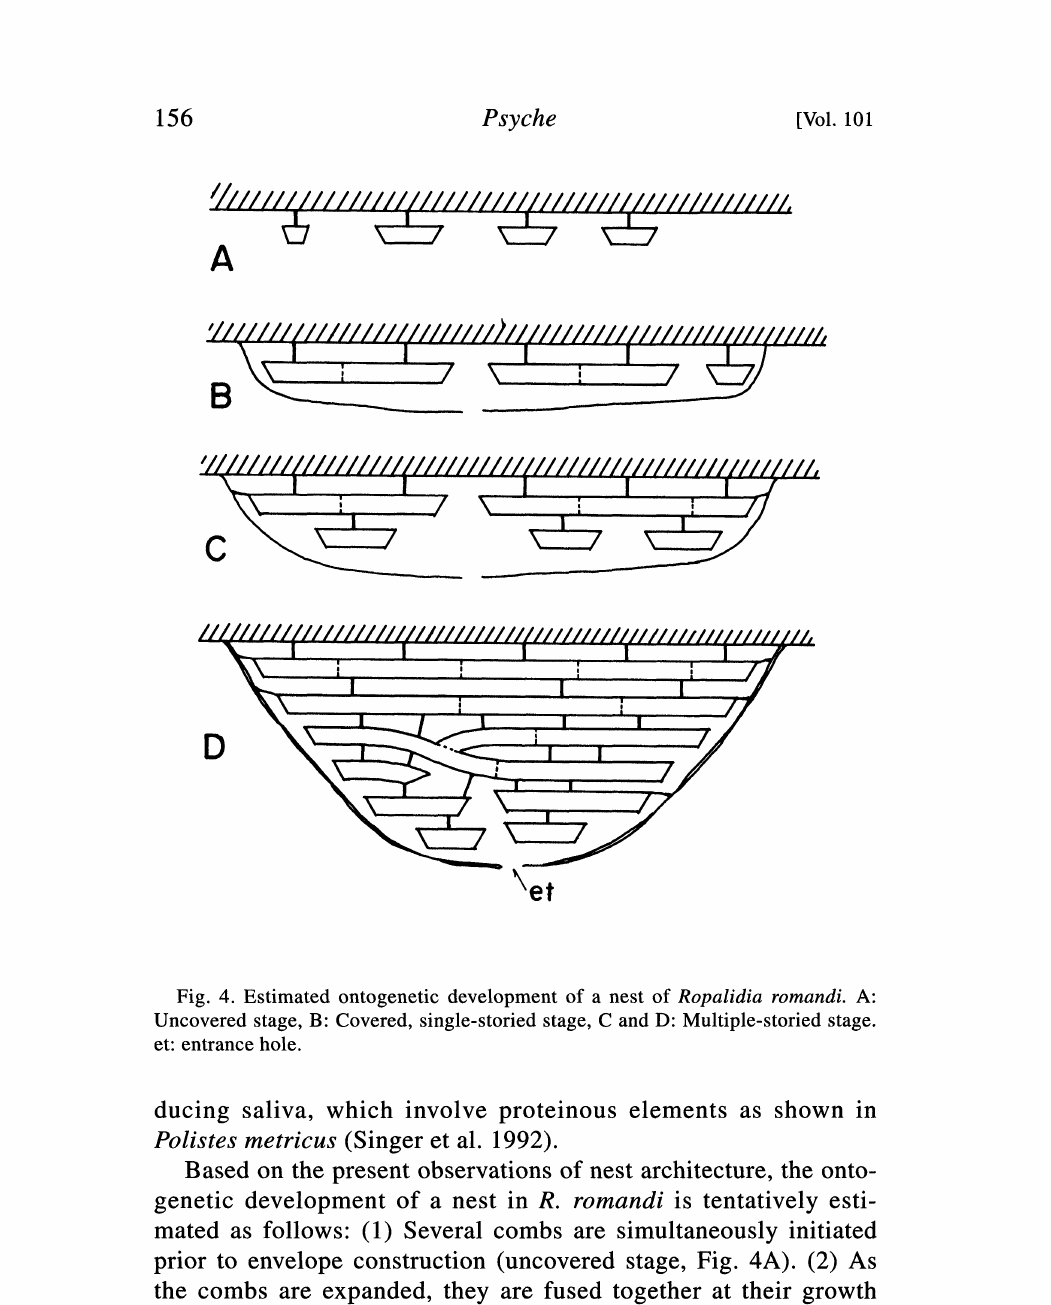
Fig. 4. Estimated ontogenetic development of a nest of Ropalidia romandi. A: Uncovered stage, B: Covered, single-storied stage, C and D: Multiple-storied stage. et: entrance